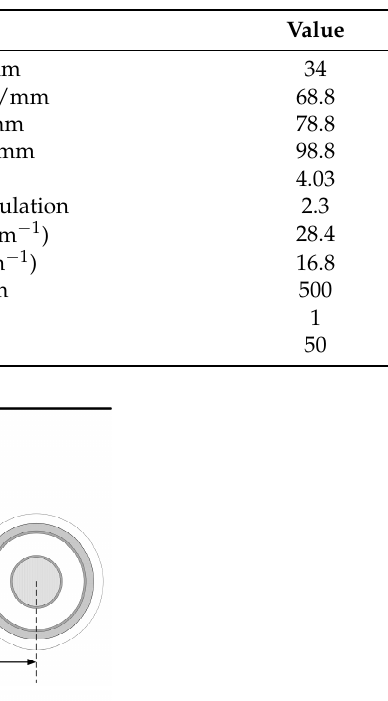
Table 3. Structural parameters of the cable.